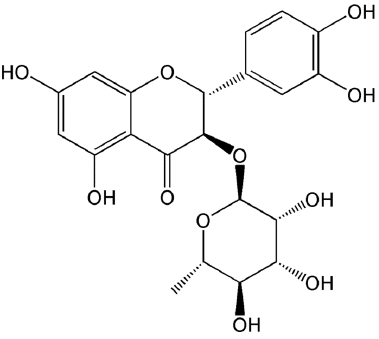
Figure 1: Chemical structure of